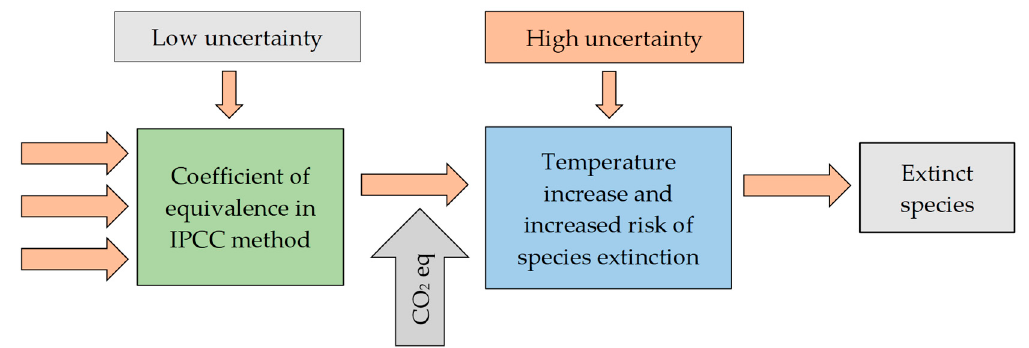
Figure 1. An example of a harmonized model of the final point regarding climate change connecting human health and damage to ecosystem.